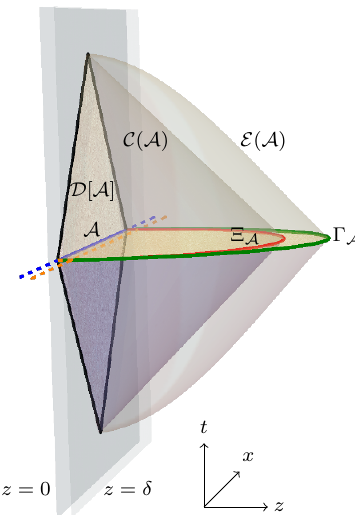
Figure 1. Schematic representation of the entanglement wedge E ( A ) and causal wedge C ( A ) associated with a boundary region A , or equivalently, with its boundary domain of dependence D [ A ]. The entanglement wedge is the bulk region bounded by null geodesics that are shot towards the boundary from the extremal surface (cid:0) A . For general bulk geometries, E ( A ) contains the causal wedge C ( A ), which is the bulk region bounded by null geodesics that are shot into the bulk from the edge of D [ A ]. The spatial surface (cid:4) A on which the latter geodesics intersect is the bifurcation surface of the causal wedge. In a few situations, (cid:4) A = (cid:0) A and the two wedges coincide, but in general cases, (cid:0) A reaches deeper into the bulk. This property has been rigorously shown to hold for generic bulk geometries in Einstein gravity but the proof does not apply for higher order derivative gravities. However, consistency of subregion-subregion duality implies that it should be true for any theory with a physically sensible holographic